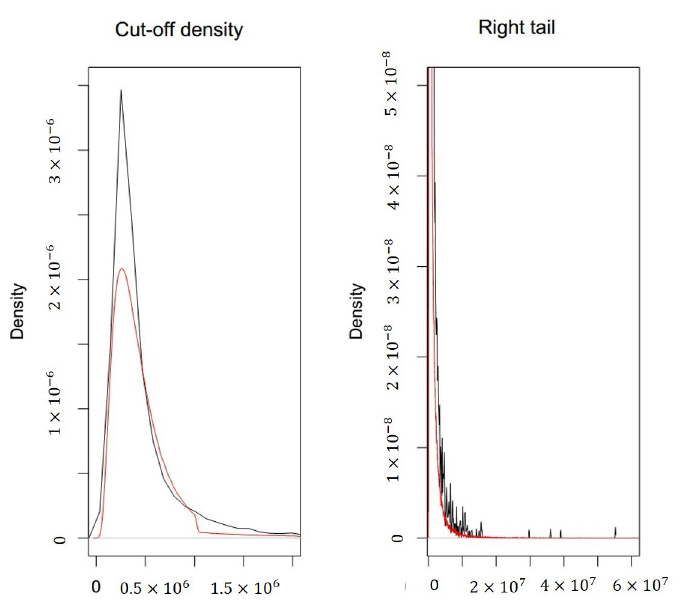
Figure 6. Left, comparison between cut-off density functions. Right, empirical and theoretical (red) right tail.